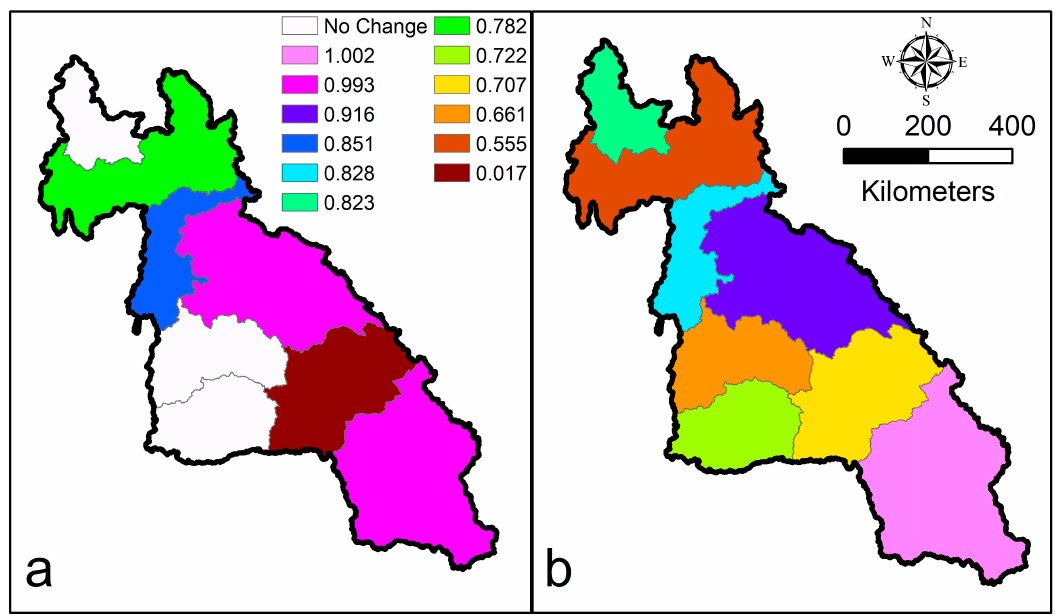
Figure 5. Precipitation data adjustment layout for ( a ) in-situ station, and ( b ) satellite-based remote sensing (RS) model input. The precipitation data adjustment equals to 1+ increment , as outlined in